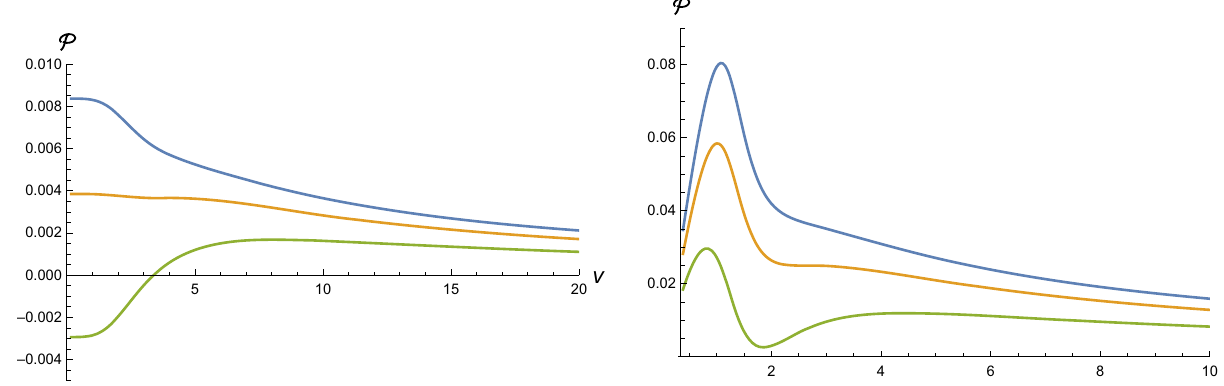
Fig. 7 P – v diagrams of charged dilatonic AdS black hole for N = 1 in five and six dimensions. We set the electric charge Q = 10. The temperatures of the lines from top to bottom are T = 1 . 2 T c , T c , and 0 . 7 T c , respectively